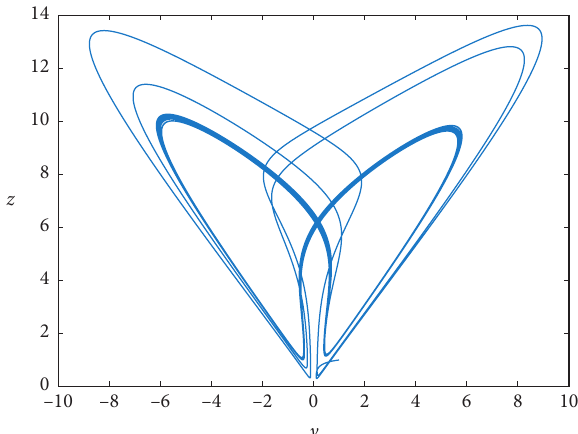
Figure 18: Dynamics of the fractional-order system in (13)–(15) with the order α � 0 . 92, in context of y and z directions.